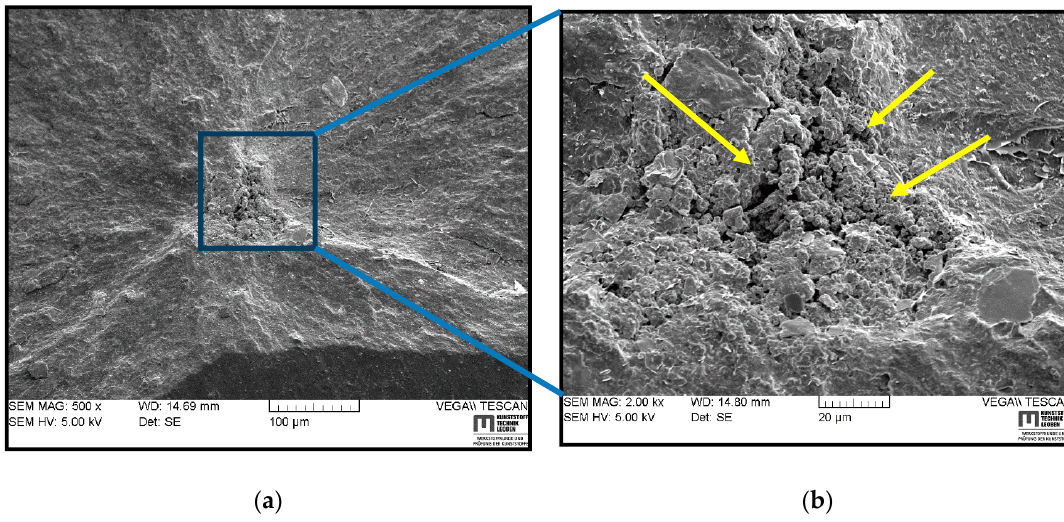
Figure 9. SEM images of a fracture surface starting from inherent voids of HNBR4 in different magnifications: ( a ) fracture initiation and propagation; ( b ) magnified view of fracture initiation and cracks into the material.